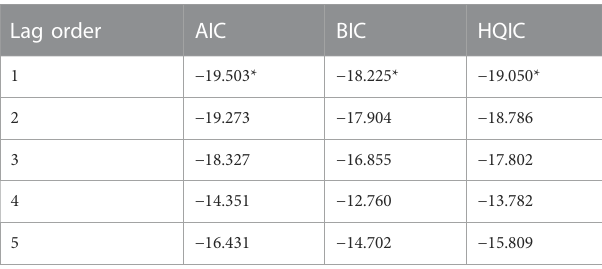
TABLE 4 Selection of optimal lag order of PVAR model. Lag order